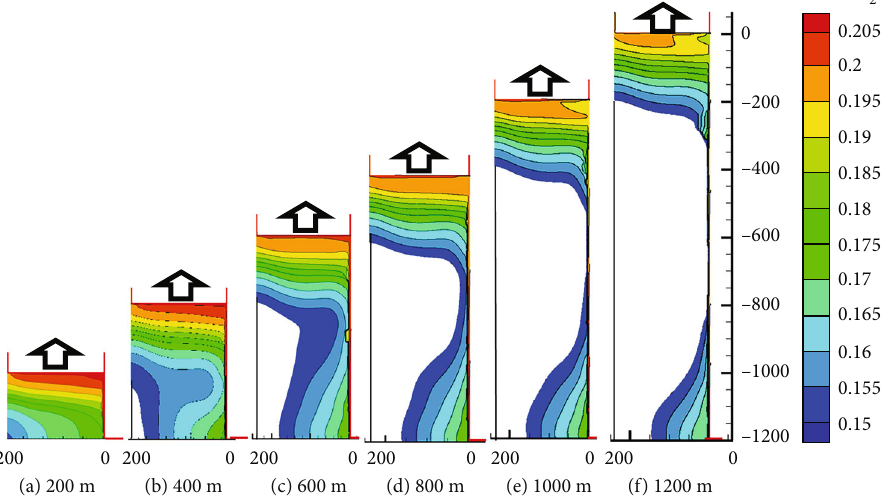
Figure 10: Goaf spontaneous combustion risk areas at di ff erent working face advancement positions.